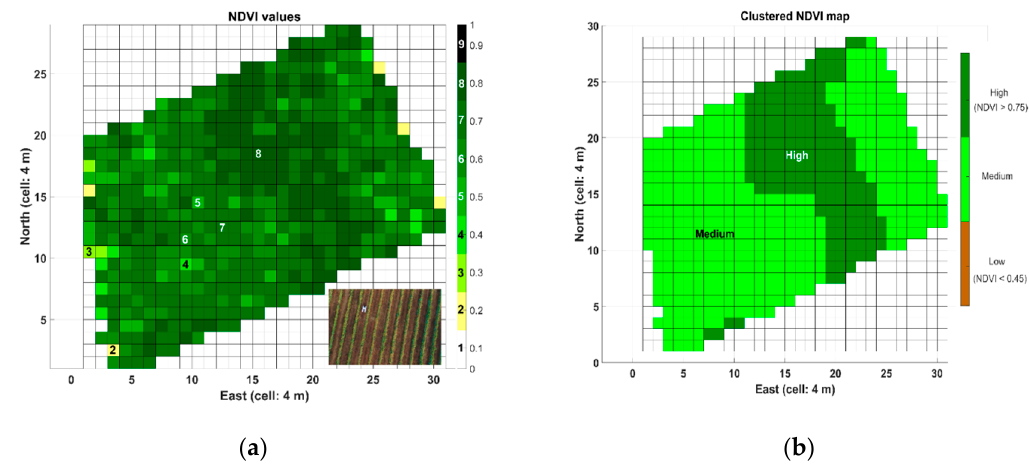
Figure 3. Grid maps of NDVI (Normalized Di ff erence Vegetation Index) without zoning ( a ), and after applying a clustering algorithm ( b